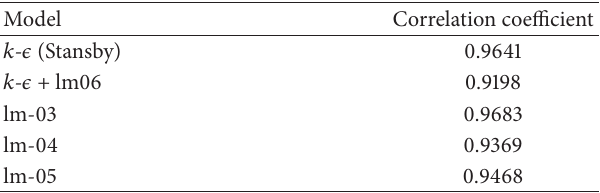
Table 3: Coefficient in relation to the Fourier domain. Model Correlation coefficient